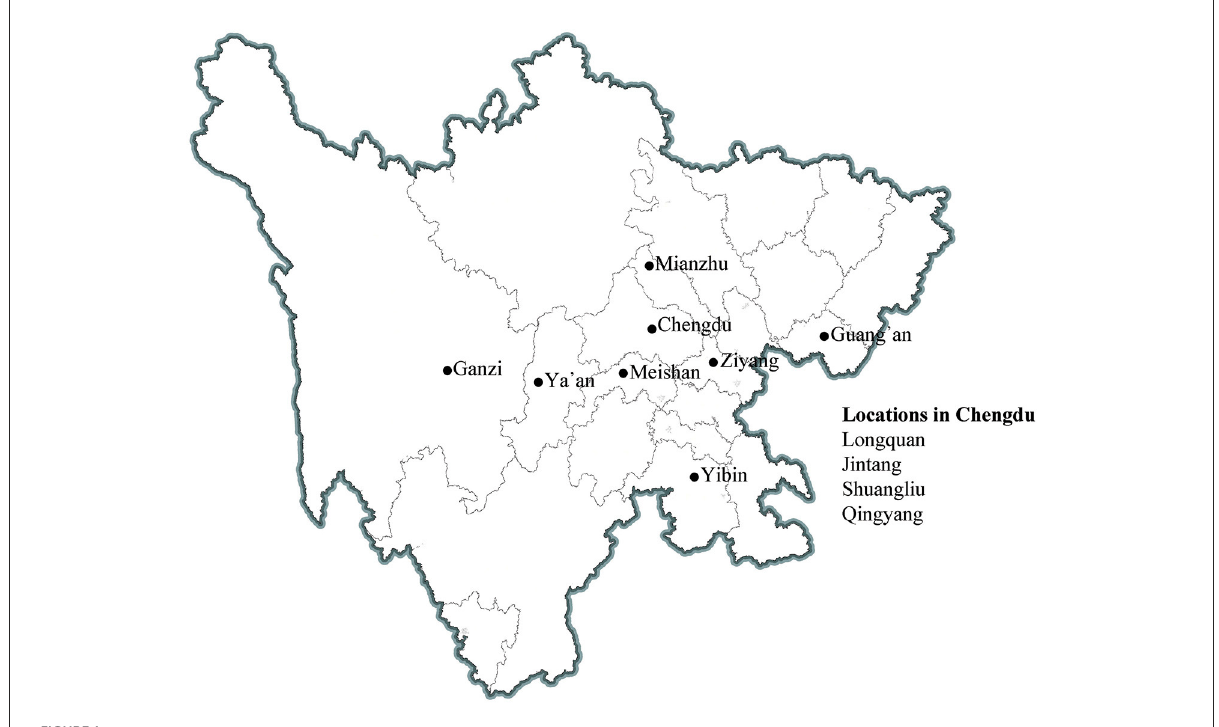
FIGURE1 Locations of 11 survey sites in Sichuan Province.